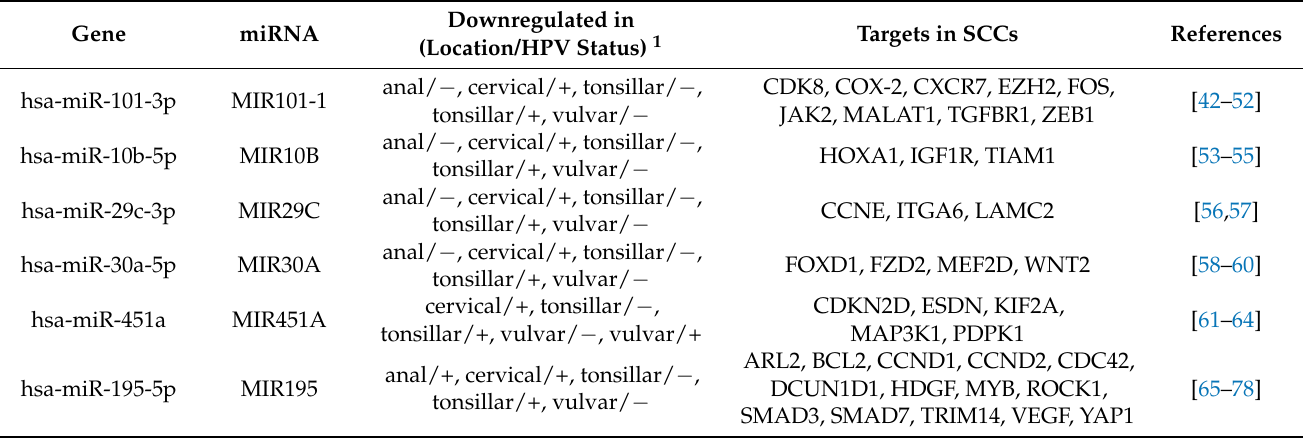
Table 1. The most commonly deregulated miRNAs which exhibited downregulation in 5/7 studied tumor types. All the listed miRNAs were demonstrated to act as tumor suppressor miRNA in SCCs, based on their experimentally confirmed characteristics relevant to carcinogenesis (invasiveness,